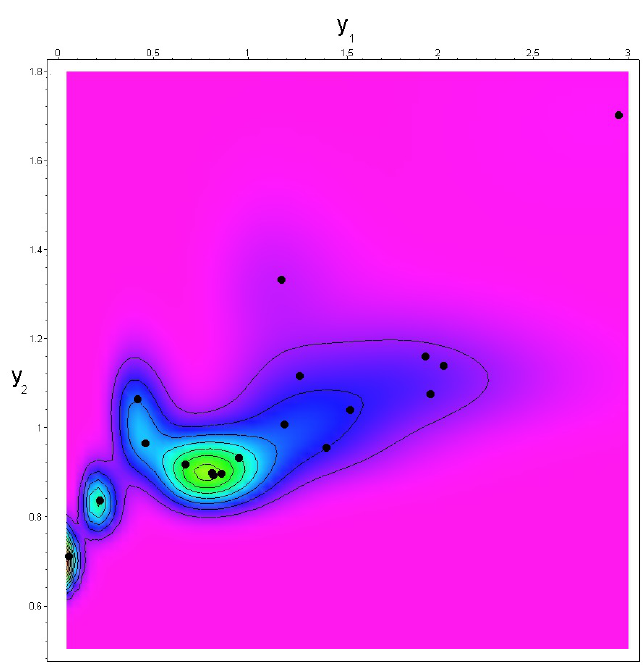
Figure 11. Contour plot of ˆ g ( y 1 , y 2 ) , m =